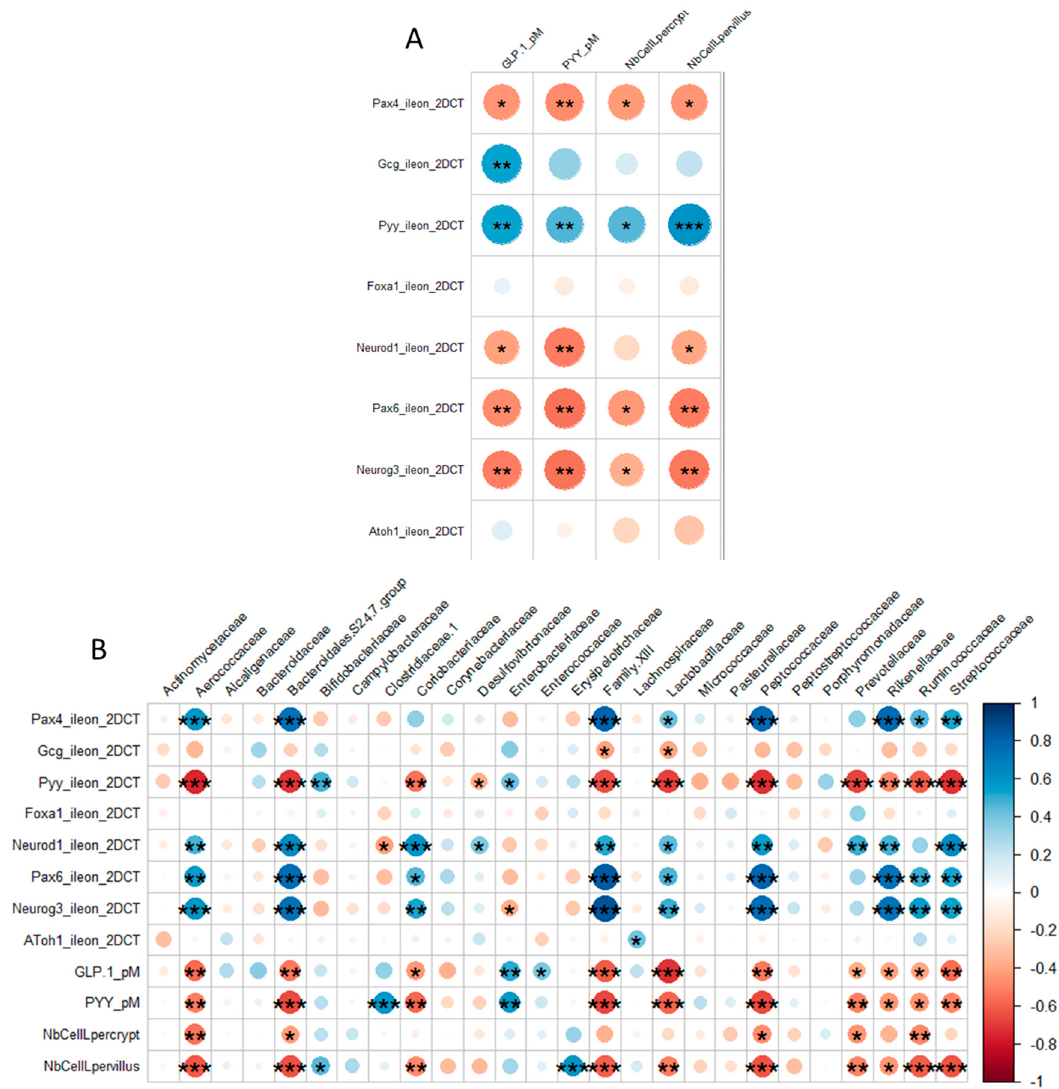
Figure 6. Correlograms within EEC descriptors ( A ) or between these descriptors and the relative abundances of main bacterial families ( B ). Positive correlations are displayed in blue and negative correlations in red. The intensity of the color and the size of the circles are proportional to the correlation coefficients. Asterisks indicate the level of significance (*, p < 0.05; **, p < 0.01; ***, p < 0.001). On the right of the correlogram, the color legend shows the correspondence between correlation coefficients and colors.